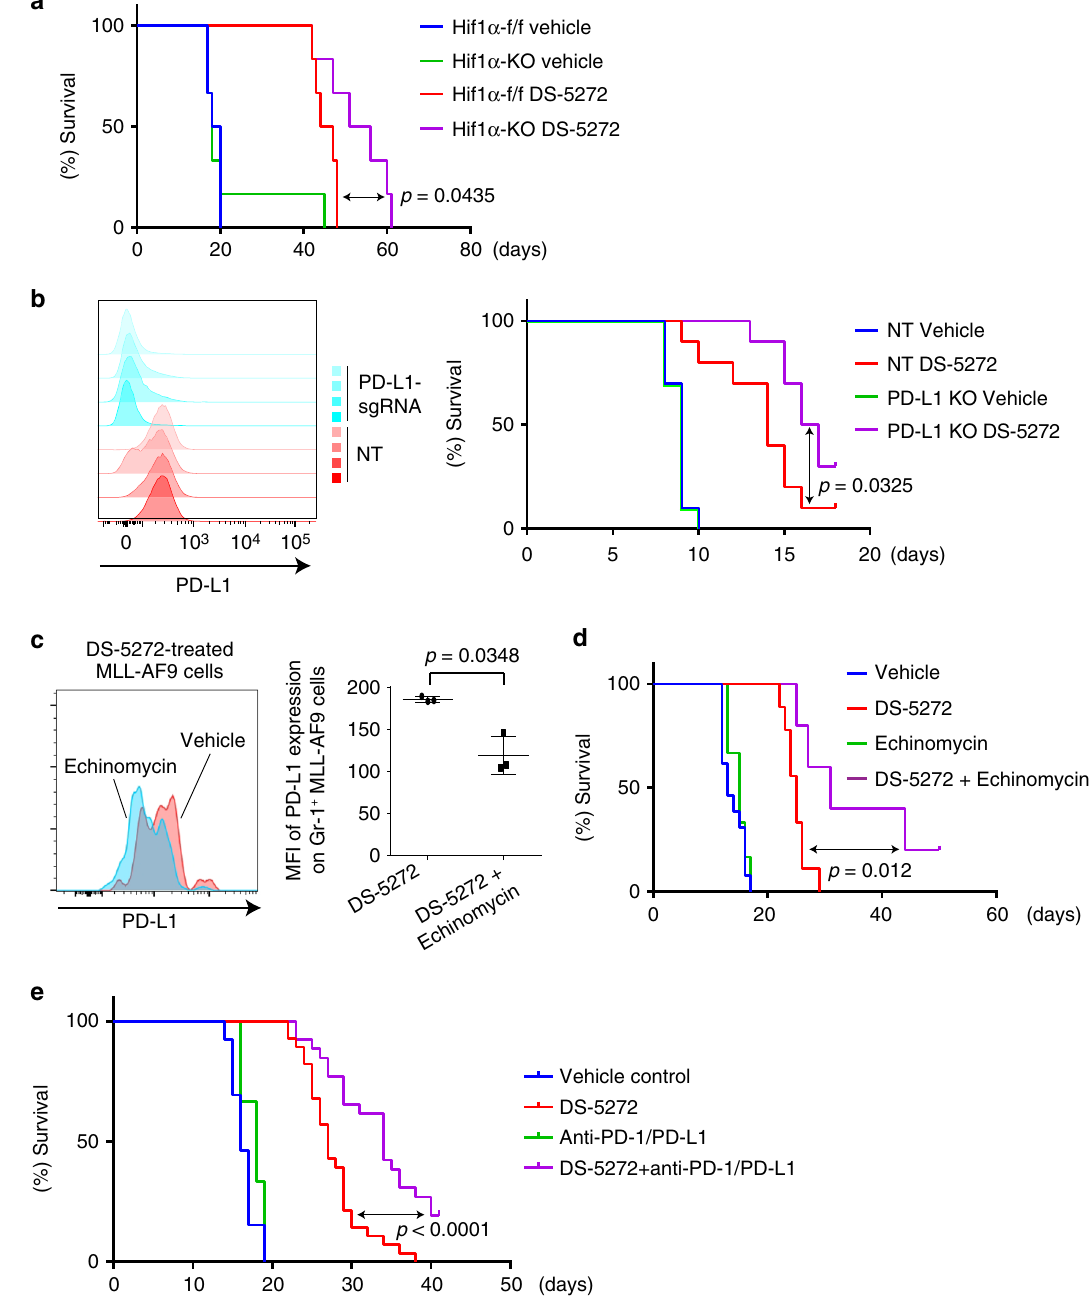
Fig. 8 Inhibition of Hif1 α -PD-L1 axis enhances the antileukemia effect of DS-5272. a MLL-AF9;CreERT2-Hif1 α -f/f leukemia cells were established as described in Fig. 4a. The leukemia cells were pretreated with EtOH or 1 μ M 4OHT for 24 h and were transplanted into recipient mice. Kaplan – Meier survival curves of these leukemic mice treated with vehicle or DS-5272. ( n = 6 per group). Statistical signi fi cance was evaluated by the log rank test. b (left) Cell surface expression of PD-L1 in MLL-AF9 cells transduced with non-targeting (NT) control sgRNA or PD-L1-targeting sgRNA, showing ef fi cient knockout (KO) of PD-L1. (right) Kaplan – Meier survival curves of mice injected with control (NT) or PD-L1-depleted (PD-L1 KO) MLL-AF9 cells, that were treated with vehicle or DS-5272 ( n = 10 per group). Statistical signi fi cance was evaluated by the log rank test. c Representative FACS dot plots showing cell surface expression of PD-L1 (left), and quantitation of mean fl uorescence intensity (MFI) of PD-L1 (right) in Gr-1 + MLL-AF9 cells treated with DS-5272 or DS- 5272 + Echinomycin. Data are shown as mean ± s.d. of three biologically independent samples. Student t -test. d Kaplan – Meier survival curves of leukemic mice treated with vehicle, DS-5272, Echinomycin, or DS-5272 + Echinomycin (Vehicle: n = 13, DS-5272: n = 9, Echinomycin: n = 6, DS-5272 + Echinomycin: n = 5). Statistical signi fi cance was evaluated by the log rank test. e Kaplan – Meier survival curves of leukemic mice treated with vehicle, anti- PD-1/PD-L1, DS-5272, or DS-5272 + anti-PD-1/PD-L1. Vehicle: n = 16, DS-5272: n = 31, anti-PD-1/PD-L1: n = 6, DS-5272 + anti-PD-1/PD-L1: n =